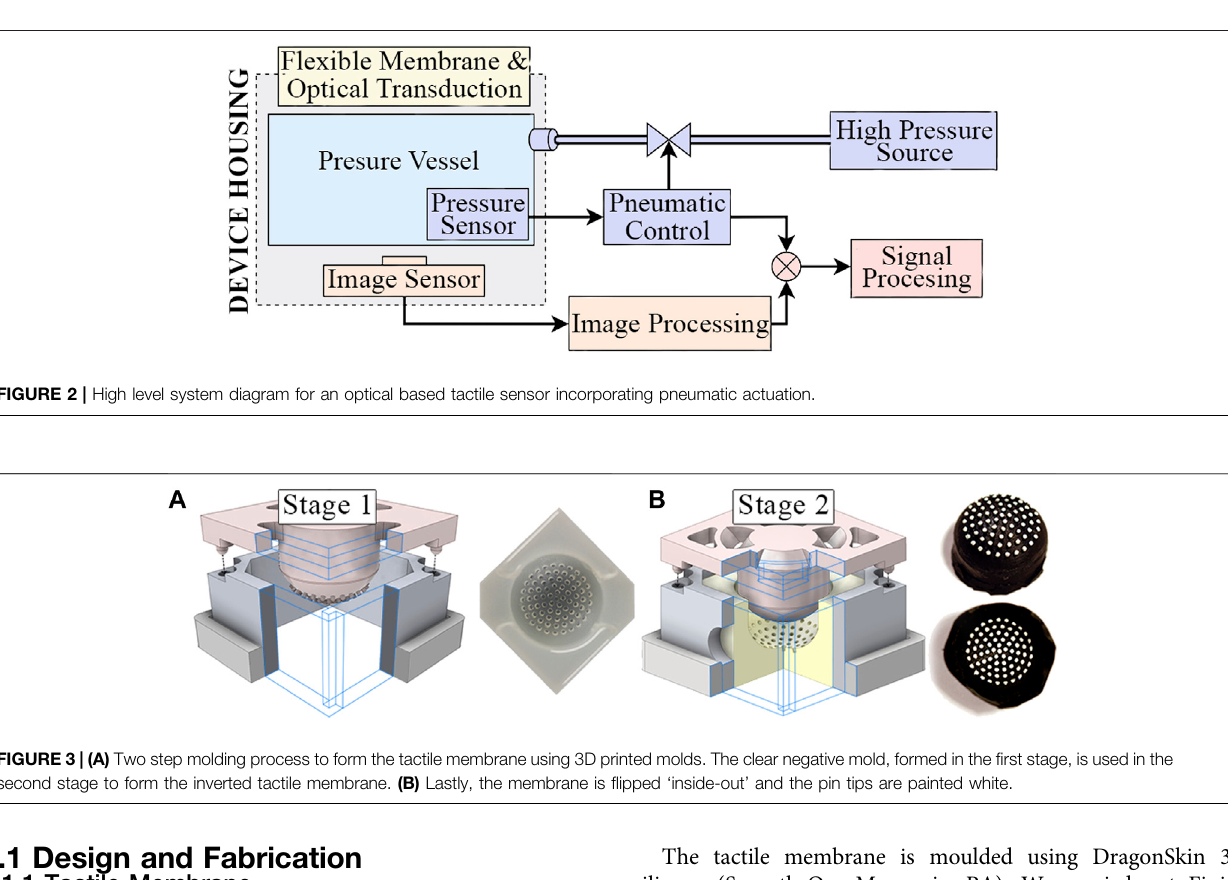
Frontiers in Robotics and AI |